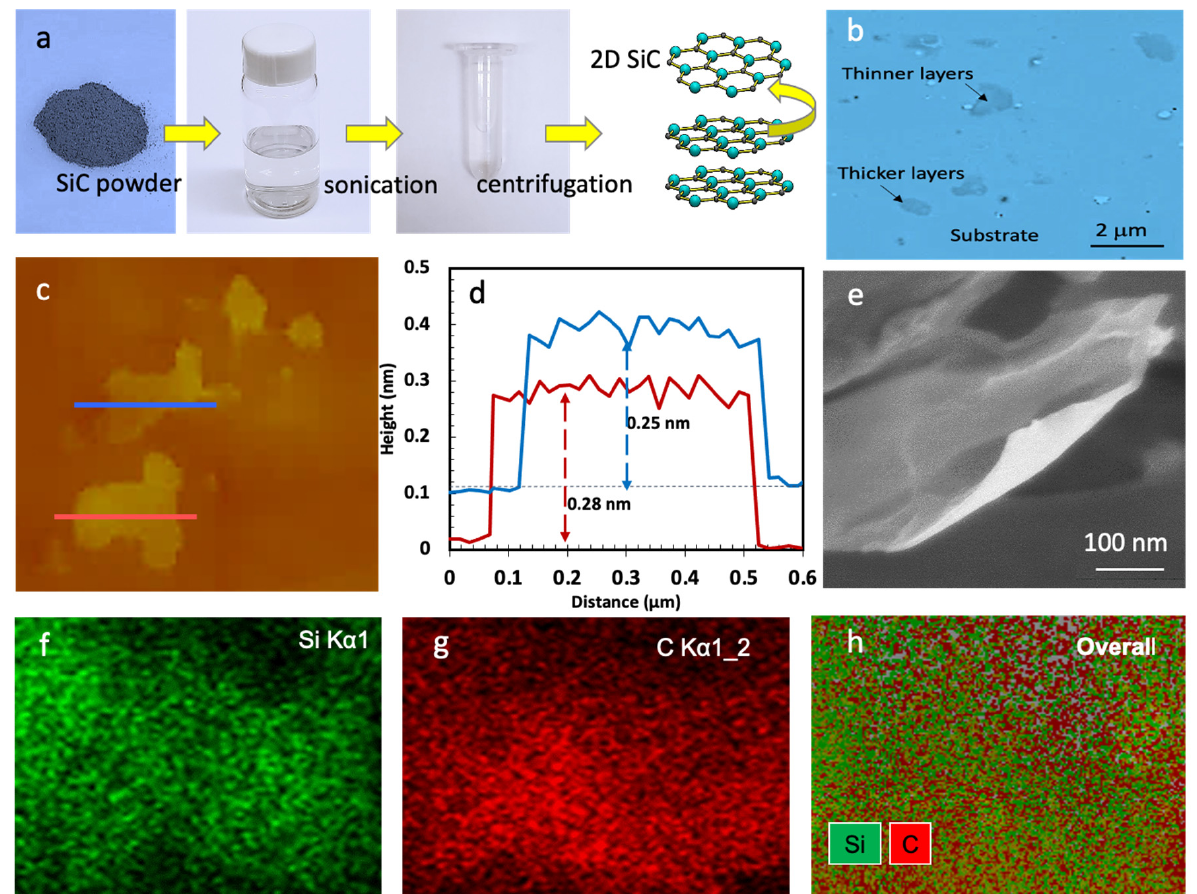
Figure 2. ( a ) Photographs of the exfoliation process and the dispersed SiC, ( b ) optical microscopy image, ( c ) AFM images, ( d ) height profiles of the SiC nanosheets marked in c, ( e ) SEM image of SiC nanosheets and ( f – h ) elemental X-ray maps for Si, C, and an RG (Si, C) composite image of the shown SiC nanosheet in Figure 2e.